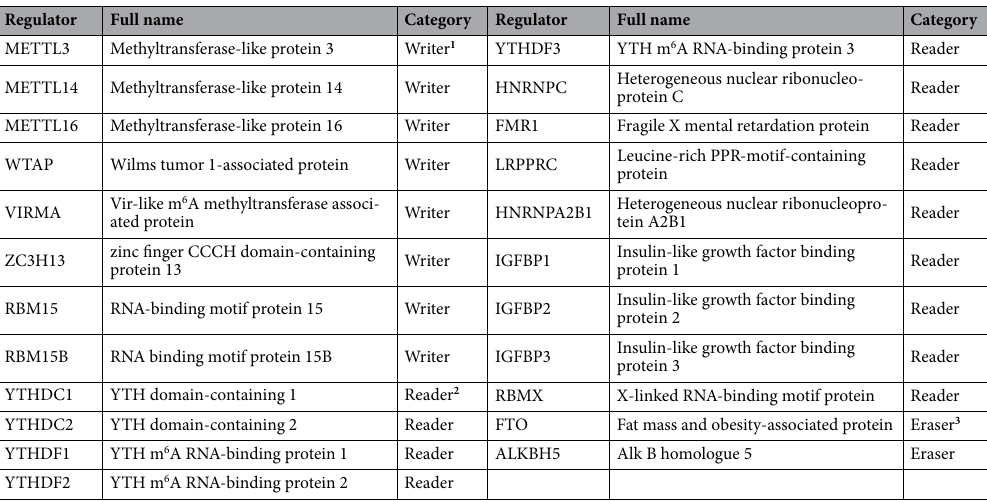
Table 1. N 6 -methyladenosine (m 6 A) regulators. 1 The m 6 A methyltransferases catalyze the formation of m 6 A as m 6 A writers. 2 The m 6 A demethylases remove the methyl codes from target RNAs as m 6 A erasers. 3 The m 6 A- binding proteins recognize and bind to the m 6 A methylation sites in RNA as m 6 A